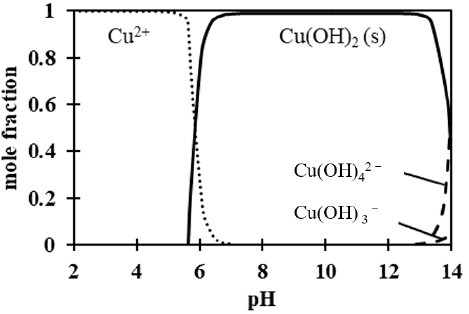
Figure A4. Dependences of Cu(II) forms on the pH value of the aqueous solutions (c 0 = 2 mmol dm − 3 ).